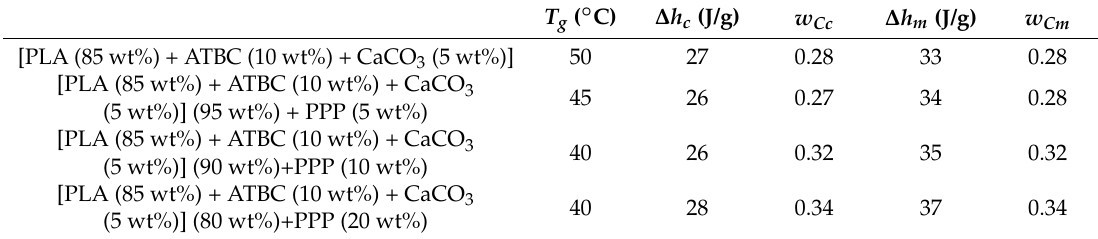
Table 3. Glass transition temperatures ( T g ), enthalpy of cold crystallization ( ∆ h c ), enthalpy of fusion ( ∆ h m ), and crystalline weight fraction growing during cold crystallization ( w Cc ) and disappearing during fusion ( w Cm ) for the PLA-based matrix and biocomposites (estimated errors: ± 0.5 ◦ C for T g ; ± 1 J/g for ∆ h c and ∆ h m , and ± 0.02 for w Cc and w Cm ). T g ( ◦ C) ∆ h c (J/g) w Cc ∆ h m (J/g) w Cm [PLA (85 wt%) + ATBC (10 wt%) + CaCO 3 (5 wt%)] [PLA (85 wt%) + ATBC (10 wt%) + CaCO